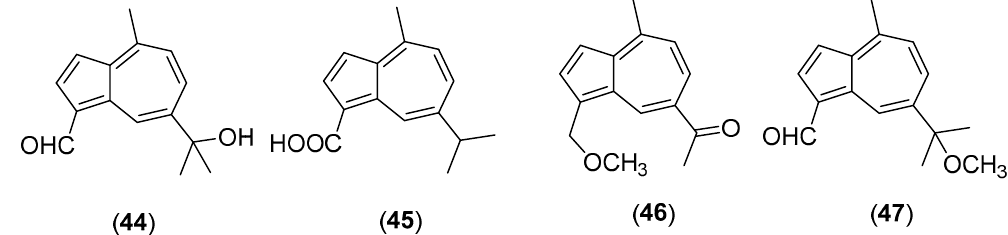
Figure 10. Chemical structures of selected compounds isolated from Lactarius hatsudake.